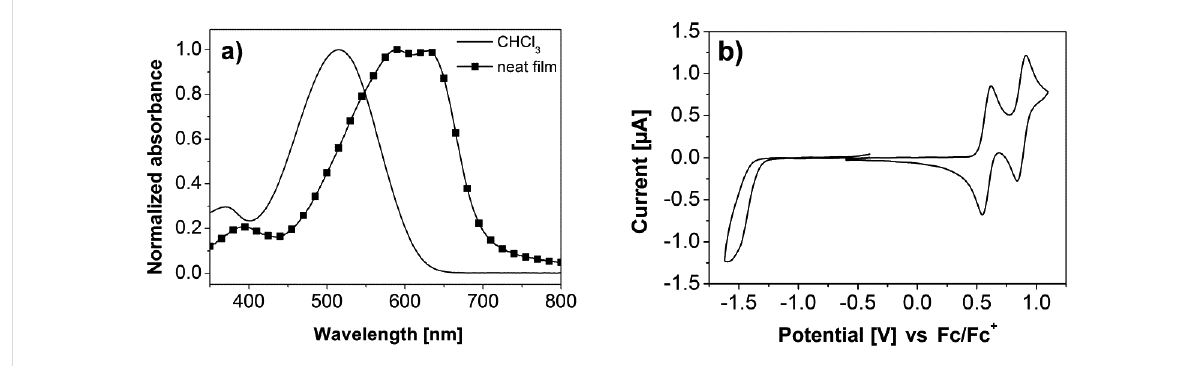
Figure 1: (a) Absorption spectrum of DCV5T-Bu 4 measured in chloroform and as thin film, spin-coated from chlorobenzene at 80 ˚ C. (b) Cyclic voltammogram of DCV5T-Bu 4 in dichloromethane, TBAPF 6 (0.1 M) measured versus the ferrocene/ferrocenyl (Fc/Fc + ) redox couple.